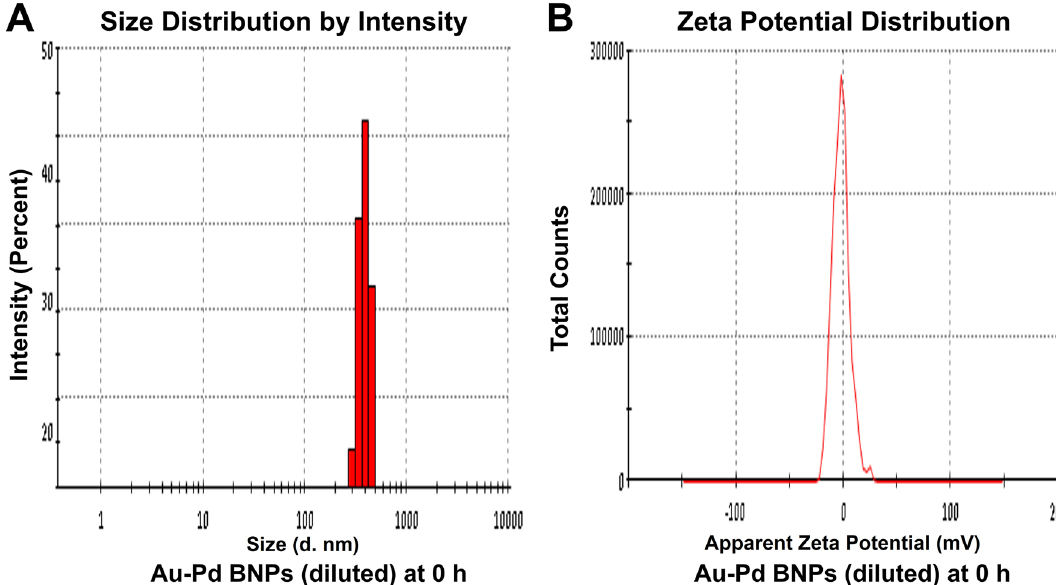
Figure 5. ( A ) DLS analysis and ( B ) Zeta Potential analysis, of the diluted (1:10) sample of 2 mM synthesized Au–Pd BNPs using 10% aqueous leaf extract of the plant Citrus limon at 0 h of synthesis.